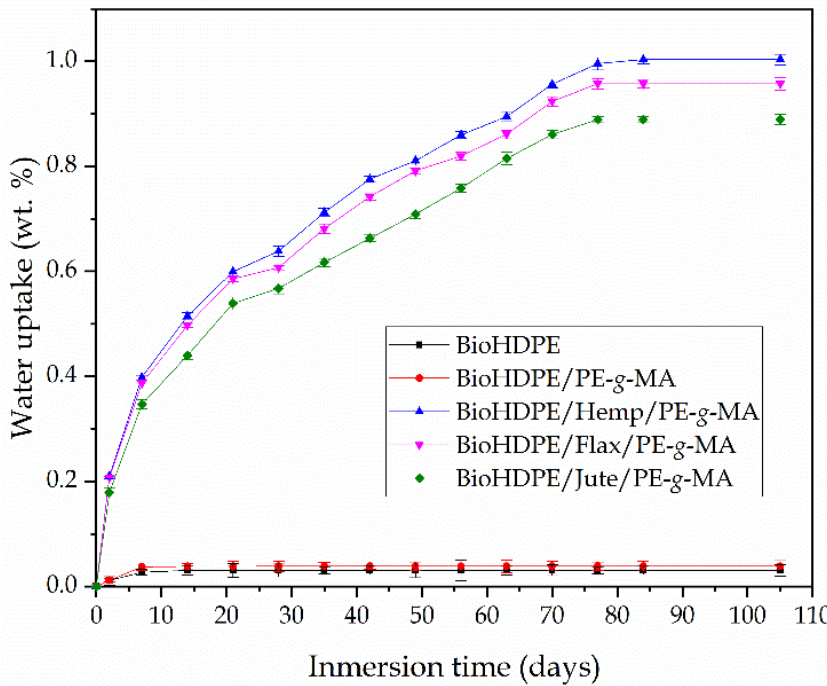
Figure 9. Water uptake of bioHDPE composites with different natural fibers. The neat bioHDPE sample did not exhibit hardly any water absorption, with an asymptotic value of approximately 0.03 wt.%. This observation demonstrates the intrinsic hydrophobic behavior of this material. Addition of PE- g -MA leads to a slight increase in water absorption, obtaining an asymptotic value of 0.04 wt.%, since PE- g -MA contains highly hydrophilic groups (maleic anhydride), thus contributing to an increased affinity towards water